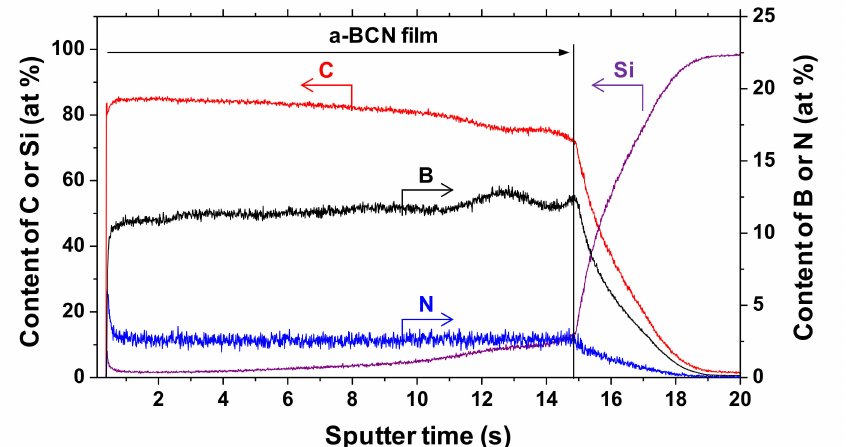
Figure 3. Glow discharge optical emission spectroscopy (GDOES) depth profile of chemical composition of the a-BCN film.